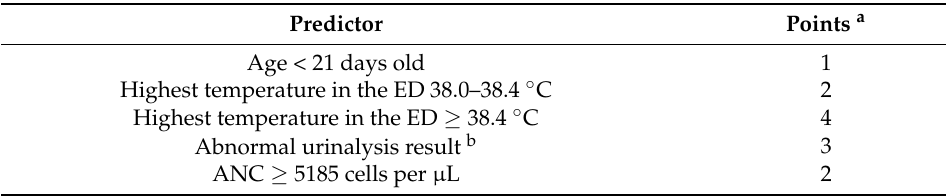
Table 1. Invasive bacterial infection (IBI) score. Predictor Points a Age < 21 days old 1 Highest temperature in the ED 38.0–38.4 ◦ C